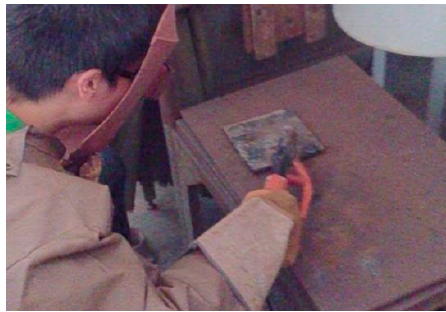
Figure 5. Wearing Safety Protective Gear for Welding.